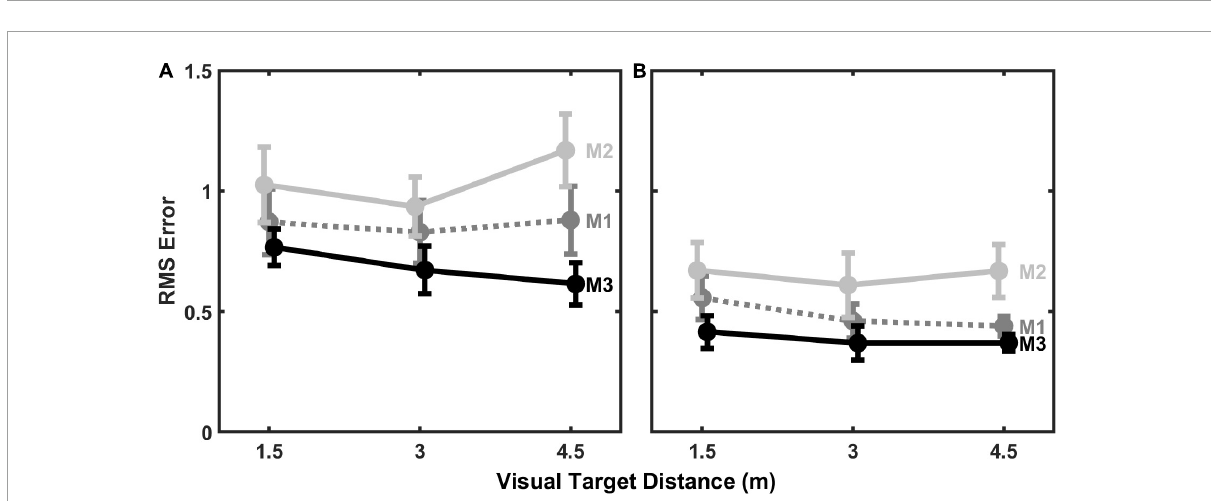
FIGURE8 Mean ( ± 1 standard error) RMS error of (A) 1-parameter ( k aud ) model fits and (B) 3-parameter ( k aud , r, σ aud ) model fits to individual subject data ( n = 11) as a function of visual target